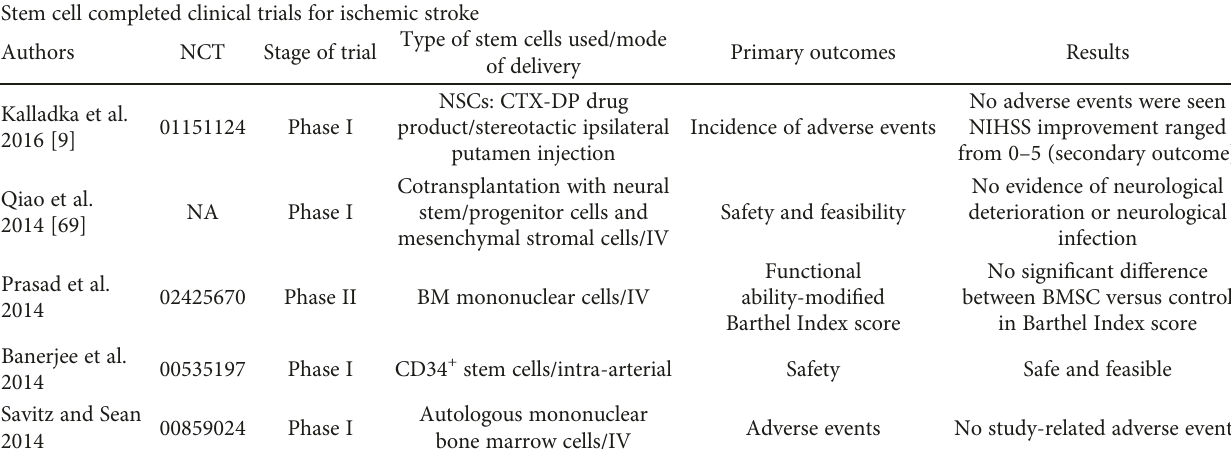
Table 1: Current completed phase I and II clinical trials on stem cell and ischemic